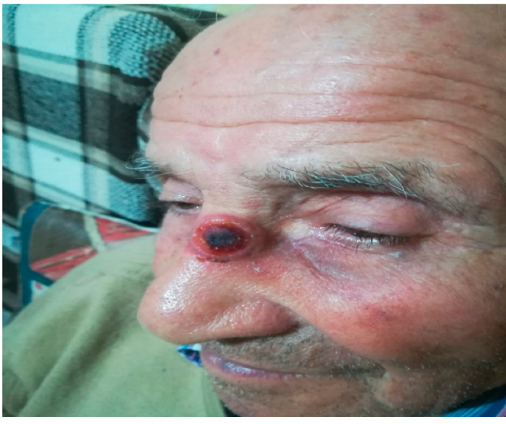
Figure 4. First visit in patient with ulcerated skin nasal lesion. Int. J. Environ. Res. Public Health 2020 , 17 , x